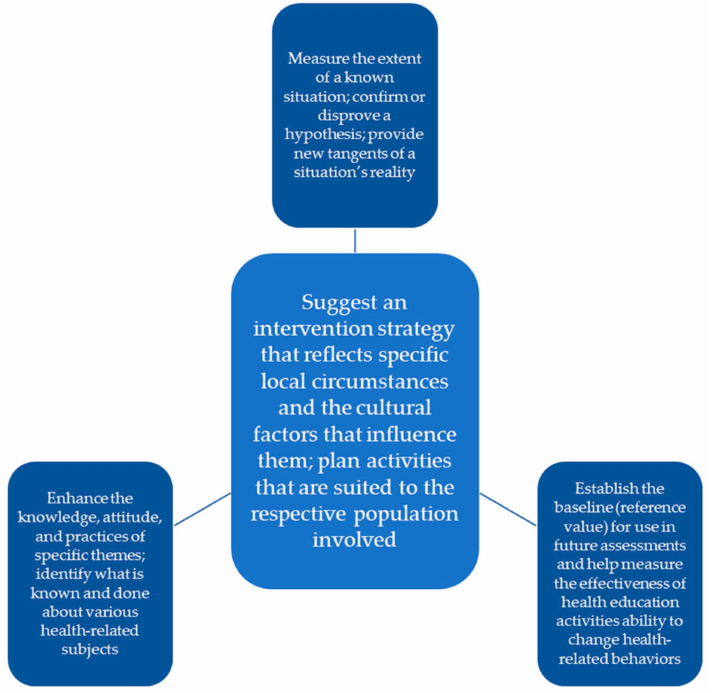
Figure 1. Knowledge, Attitudes and Practices